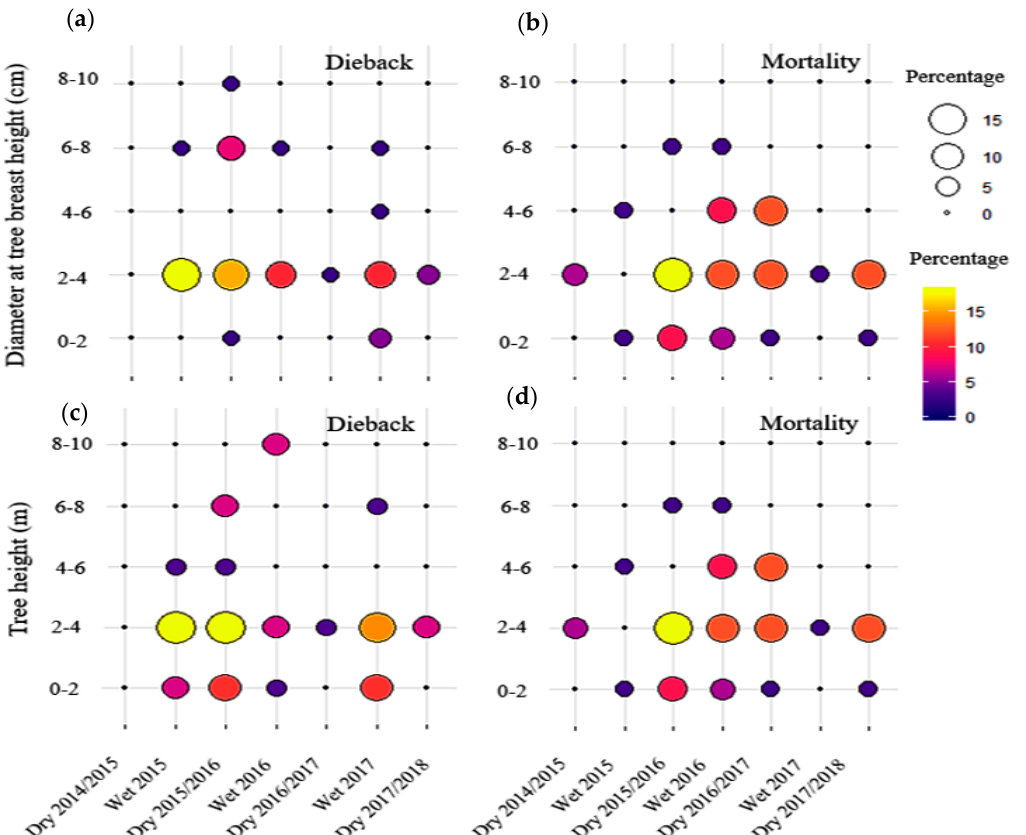
Figure 6. Dieback ( a , c ) and mortality ( b , d ) rate depending on DBH and tree height in the study DDF for each wet and dry seasons from 2014 to 2018. The size of circle from small to big indicates the percentage of tree mortality and dieback (15). The color gradient from purple to yellow also indicates the percentage of mortality and dieback in the same way as the size of circle, but helps to distinguish when the circles have similar sizes (e.g., yellow vs. orange).